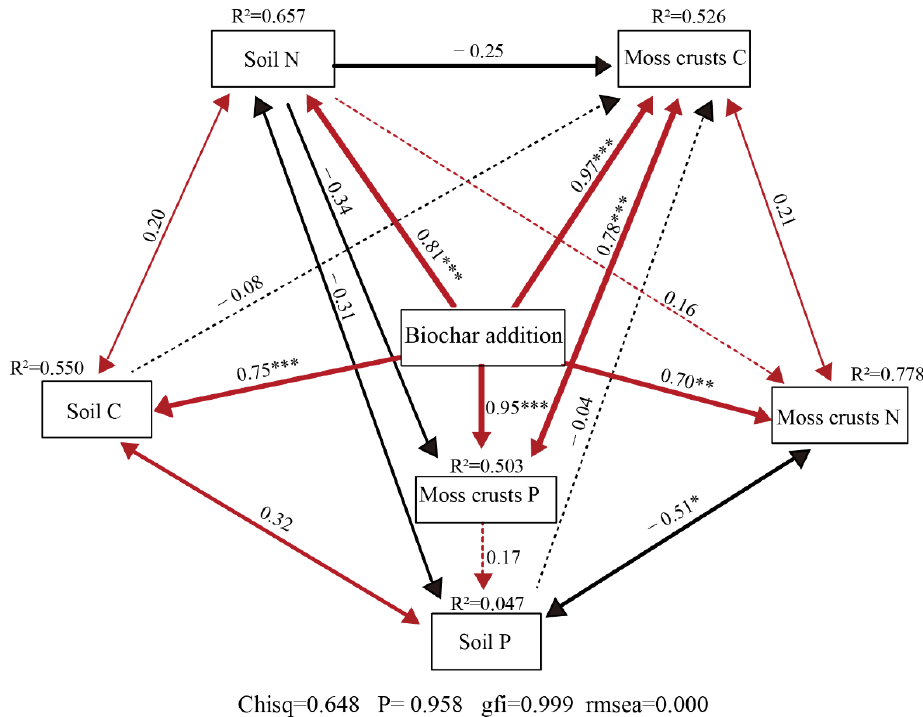
Figure 5. Structural equation model (SEMs) illustrating the effects of addition biochar on C, N, P of moss crusts and its underlying soil. Adjacent numbers that are labeled in the same direction as the arrow represents path coefficients, and the width of the arrow is in proportion to the degree of path coefficients. Blank and red arrows indicate negative and positive relationships, two ways arrows indicate mutual influence, continuous and dashed arrows represent the important and not important influence relationships, respectively. Significance levels are denoted with * p < 0.05, ** p < 0.01, and *** p < 0.001, The low chi-square (CMINDF), non-significant probability level ( p > 0.05), high goodness-of-fit index (GFI > 0.90), and low root-mean-square errors of approximation (RMSEA) listed below the SEMs indicate that our data matches the hypothetical models. SMC = soil moisture content, R 2 values indicate the proportion of variance explained by each variable.